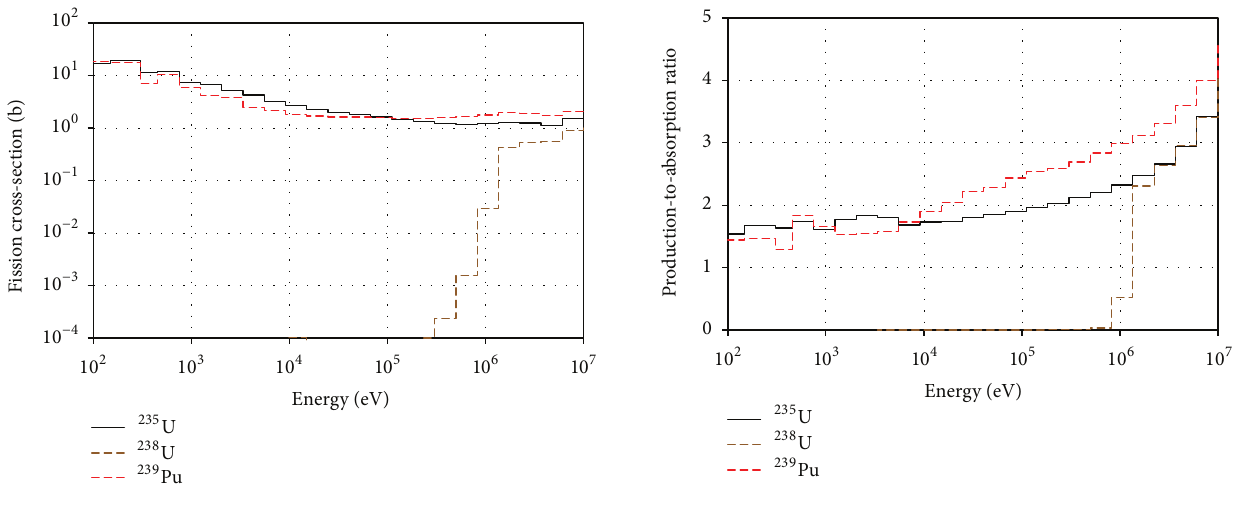
Figure 2: Fission cross-sections. Figure 3: Production-to-absorption